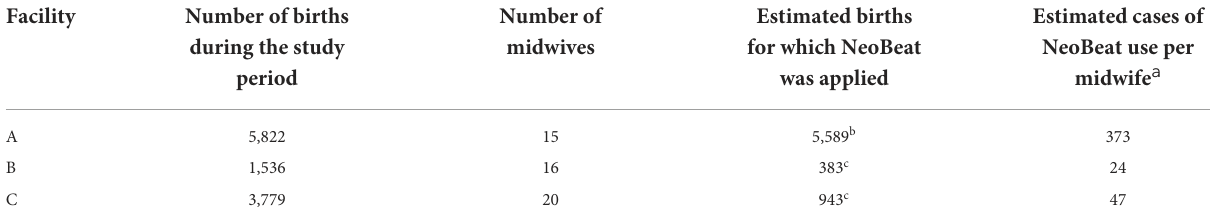
TABLE 2 Estimated frequency of use of NeoBeat per